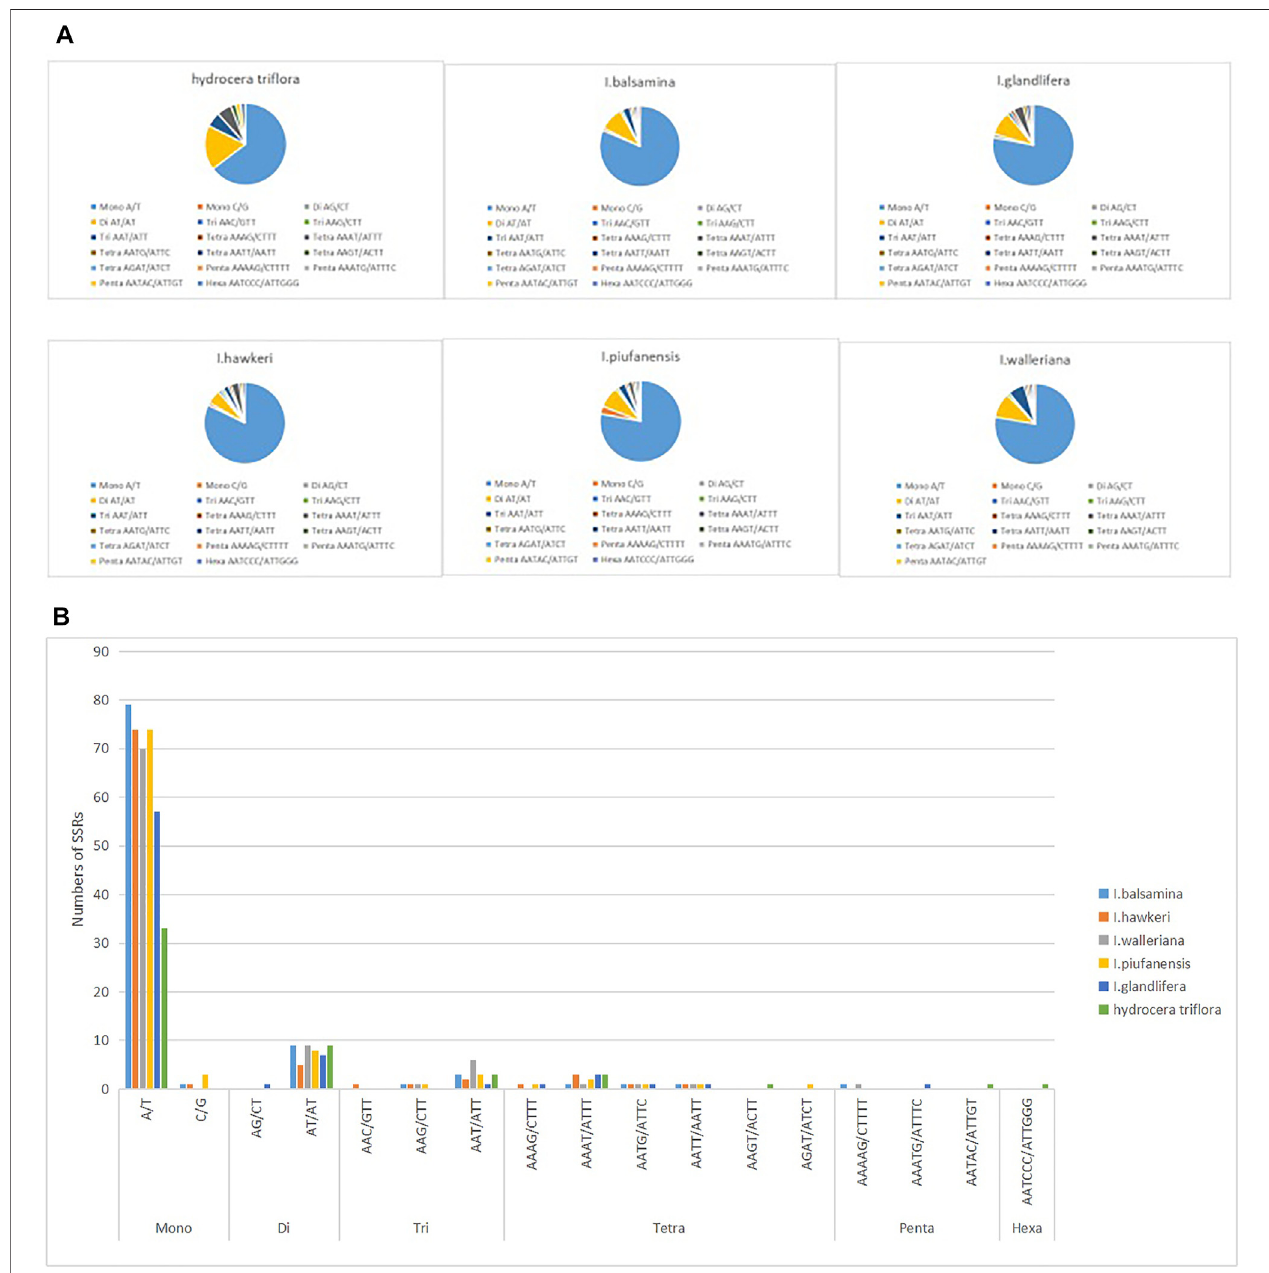
FIGURE 3 | Analysis of simple sequence repeats (SSRs) in the chloroplast genomes of I. balsamina, I. hawkeri, I. walleriana, I. piufanensis, I. glandulifera, and H. tri fl ora . (A) The number of different SSR types detected in each species; (B) type and frequency of each identi fi ed